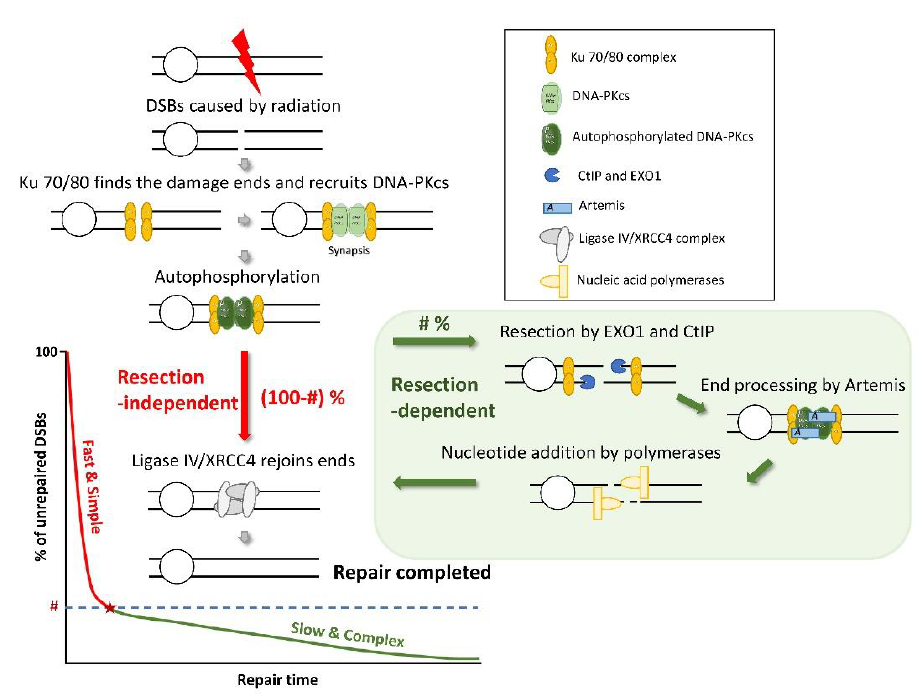
Figure 1. Scheme of the NHEJ repair pathway, including the resection-dependent compartment and the resection-independent compartment. # refers to the percentage of the resection-dependent compartment. Red and blue arrows respectively refer to the steps of the fast and slow processes, and the gray ones have shared steps.